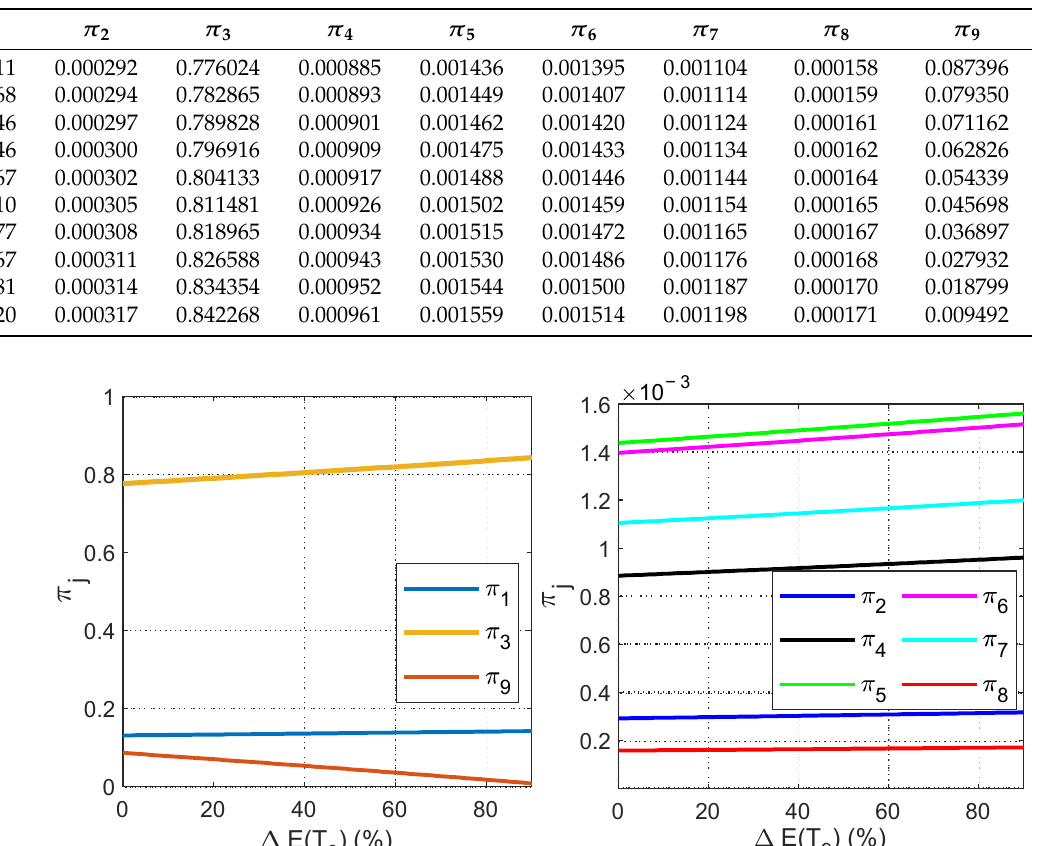
Figure 7. Ergodic probabilities of SMM obtained in simulation by reduction of the expected value of sojourn time E ( T 9 ).